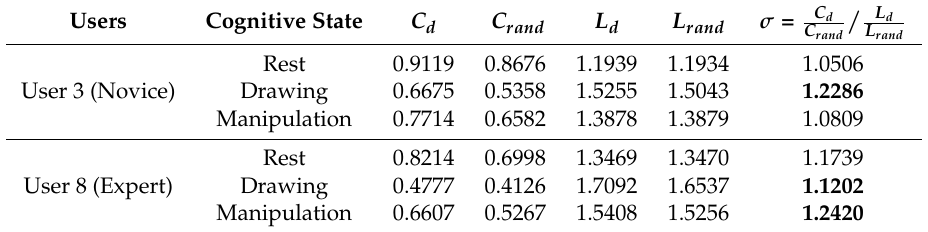
Table 3. Small-worldness of binary directed FBNs during rest, drawing and manipulation states for 2 typical